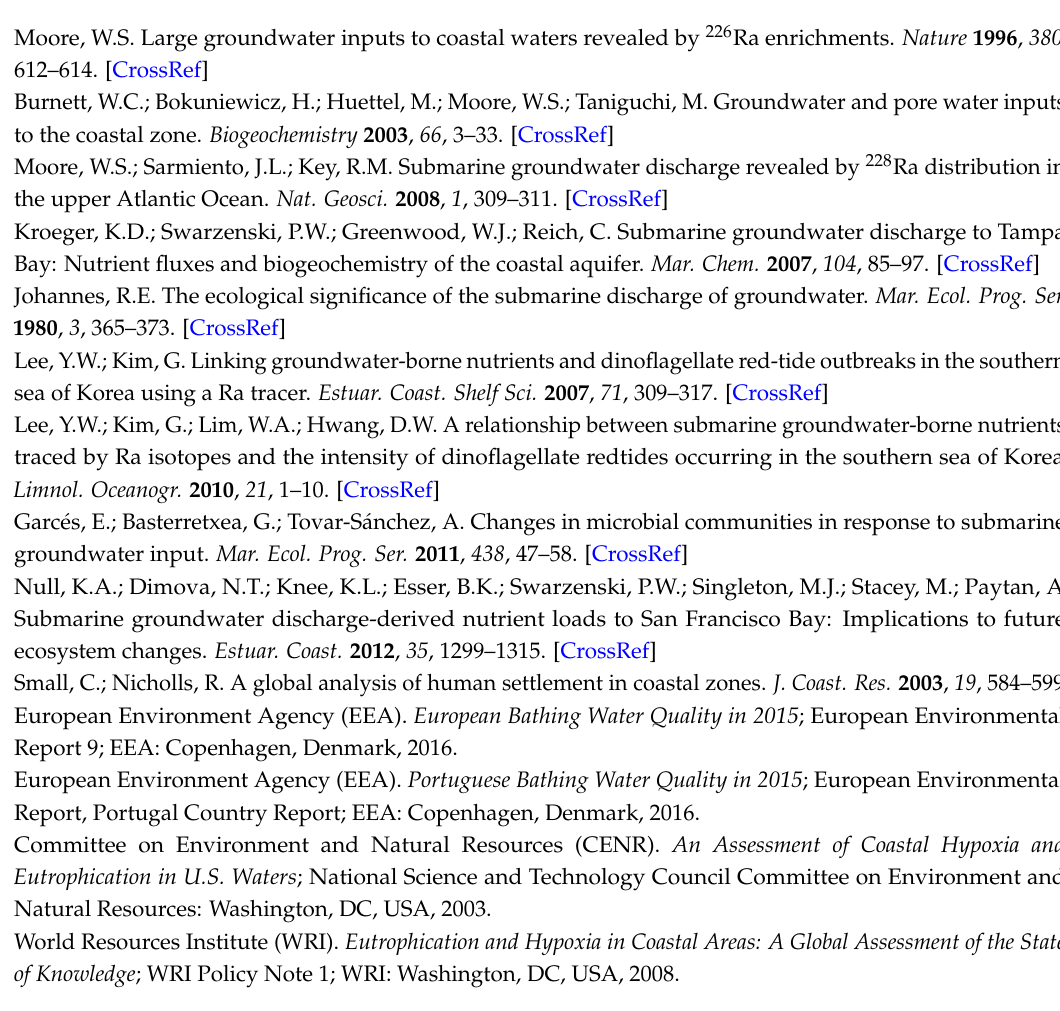
Table S1: Groundwater chemical data (mean values for the monitored springs (spr) and drilled wells (wll)), discharge (Q) and nitrates enrichment factor (EF) (SMA—Santa Maria island; SMG—S ã o Miguel; TER—Terceira; GRA—Graciosa; SJZ—S ã o Jorge; PIC—Pico; FAI—Faial; FLO—Flores; COR—Corvo; n.d. —not